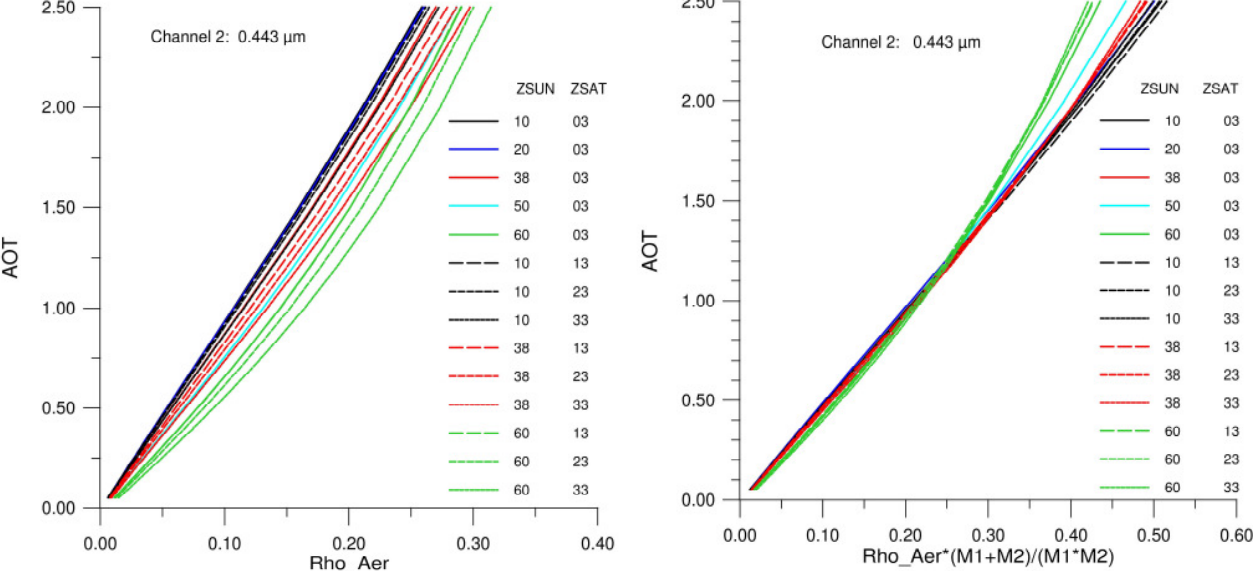
Fig. 7. Dependence of AOT on aerosol reflectance for MERIS channel 2 (0.443µm). Influence of illumination and viewing geometry on LUT (left) and after its airmass correction (right). The parameter of x-axis of right figure is the air mass - corrected aerosol reflectance given by equation